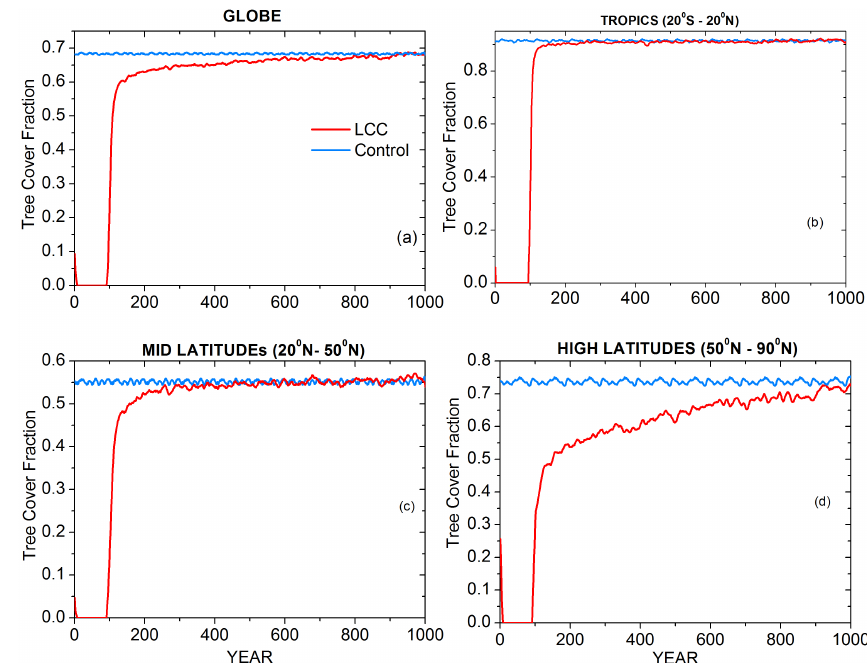
Fig. 2. Evolution of global, tropical (20 ◦ S to 20 ◦ N), mid latitude (20 ◦ N to 50 ◦ N), and high latitude (50 ◦ N to 90 ◦ N) annual mean fractional area of tree cover (Tropical evergreen, Tropical deciduous, Temperate and Boreal forests) in the control and LCC